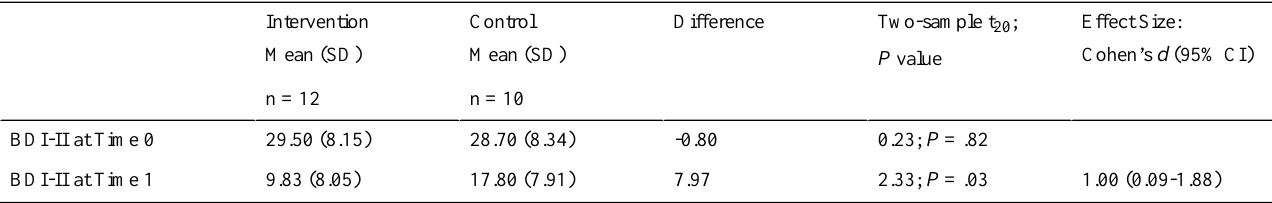
Table 3. Between-group comparison of BDI-II for available